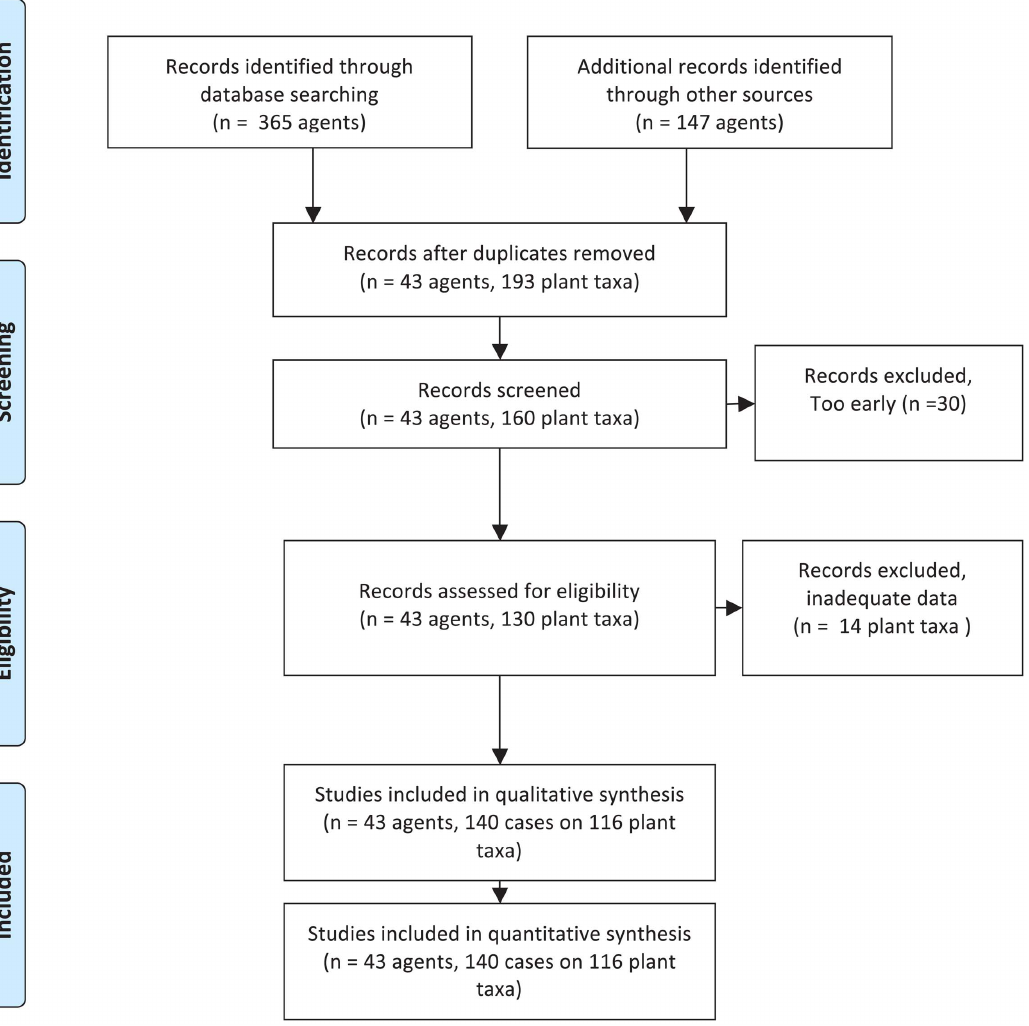
Figure 1. Modified PRISMA flow chart used in the systematic review process [ 39 ] for non-target impacts from classical biological control of weeds.